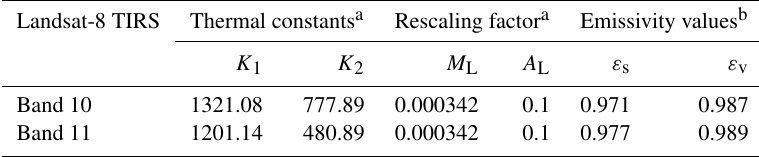
Table 5. Thermal conversion constants and rescaling factors of Landsat-8 TIRS